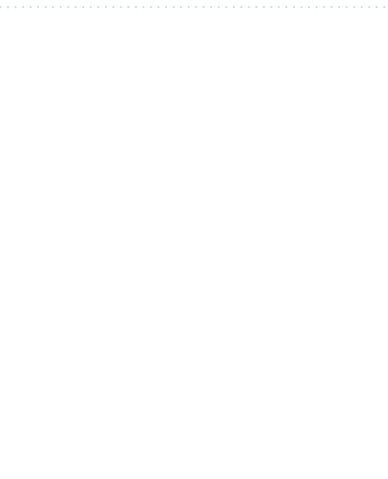
Figure 5. Force-displacements FRFs and coherence functions for surface 1 for all mounting screws tightened with the torque of: ( a ) 50 Nm, ( b ) 70 Nm, ( c ) 90 Nm, ( d ) 110 Nm, ( e ) 130 Nm.